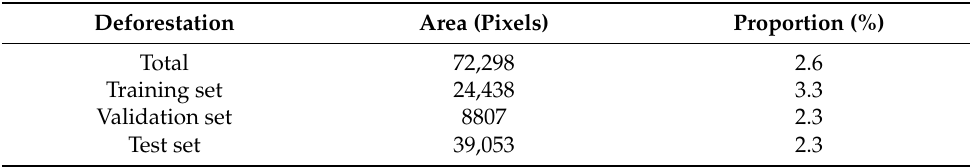
Table 2. Deforestation area in the study